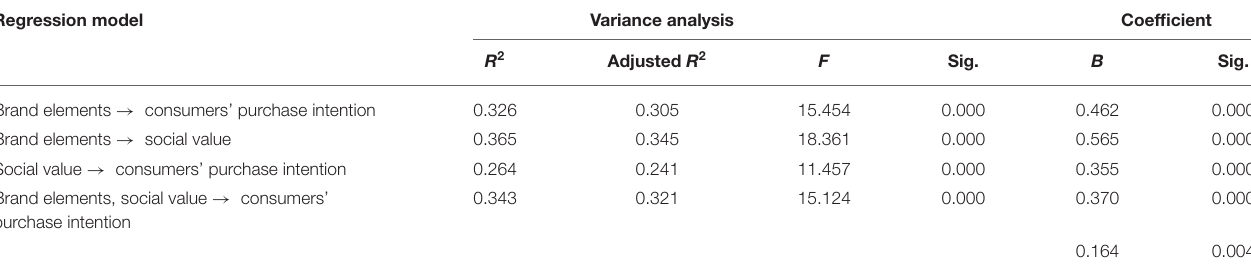
TABLE 13 | Intermediary role played by the social value. Regression model